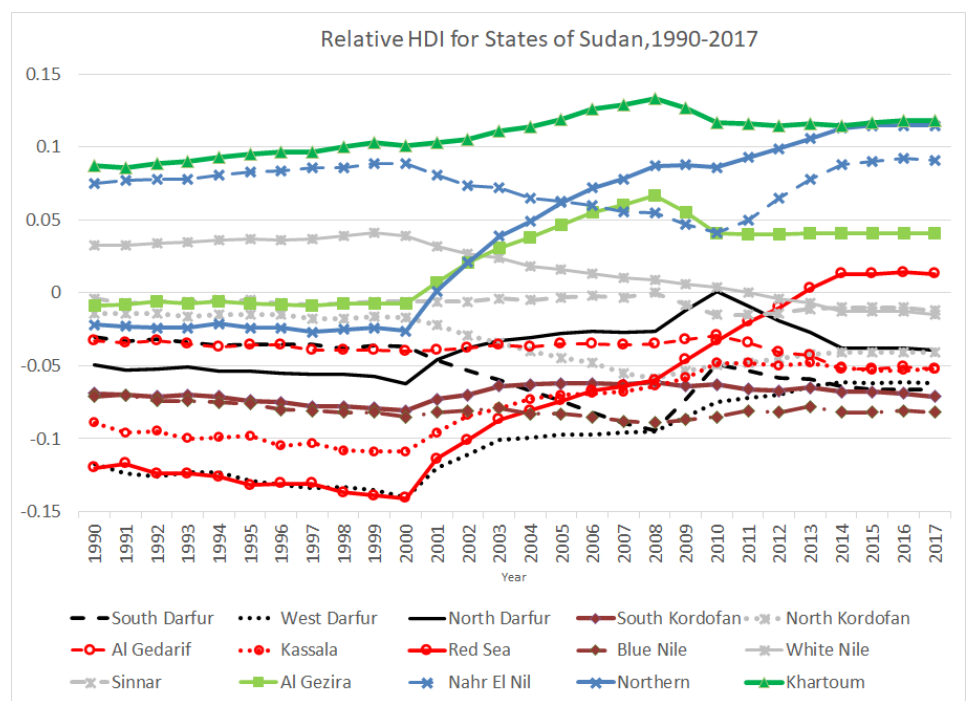
Figure 2. Relative human development index (HDI) (0 = Sudan average) of modern states of Sudan, 1990–2017. States in the same region are denoted by lines of the same color. Data were obtained from Global_Data_Lab